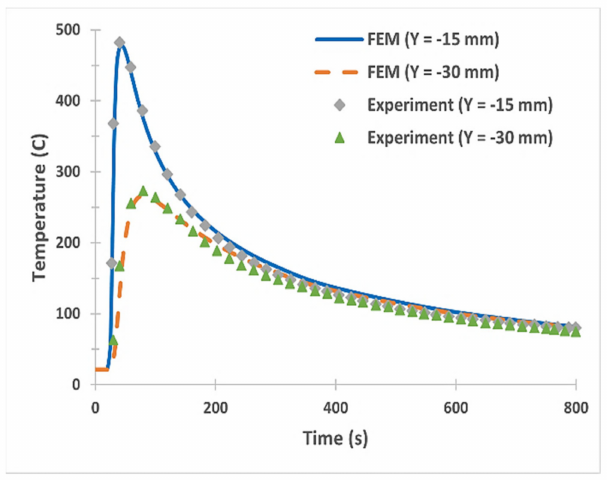
Figure 6. Temperature time-history curves.